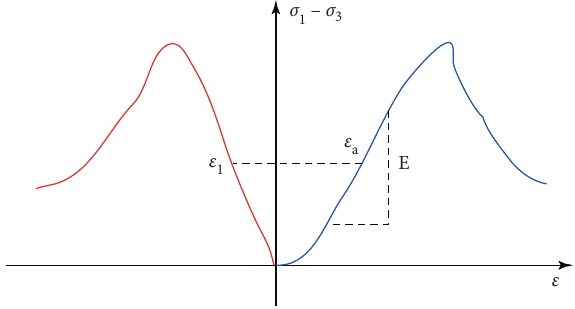
Figure 8: The schematic diagram for elasticity modulus